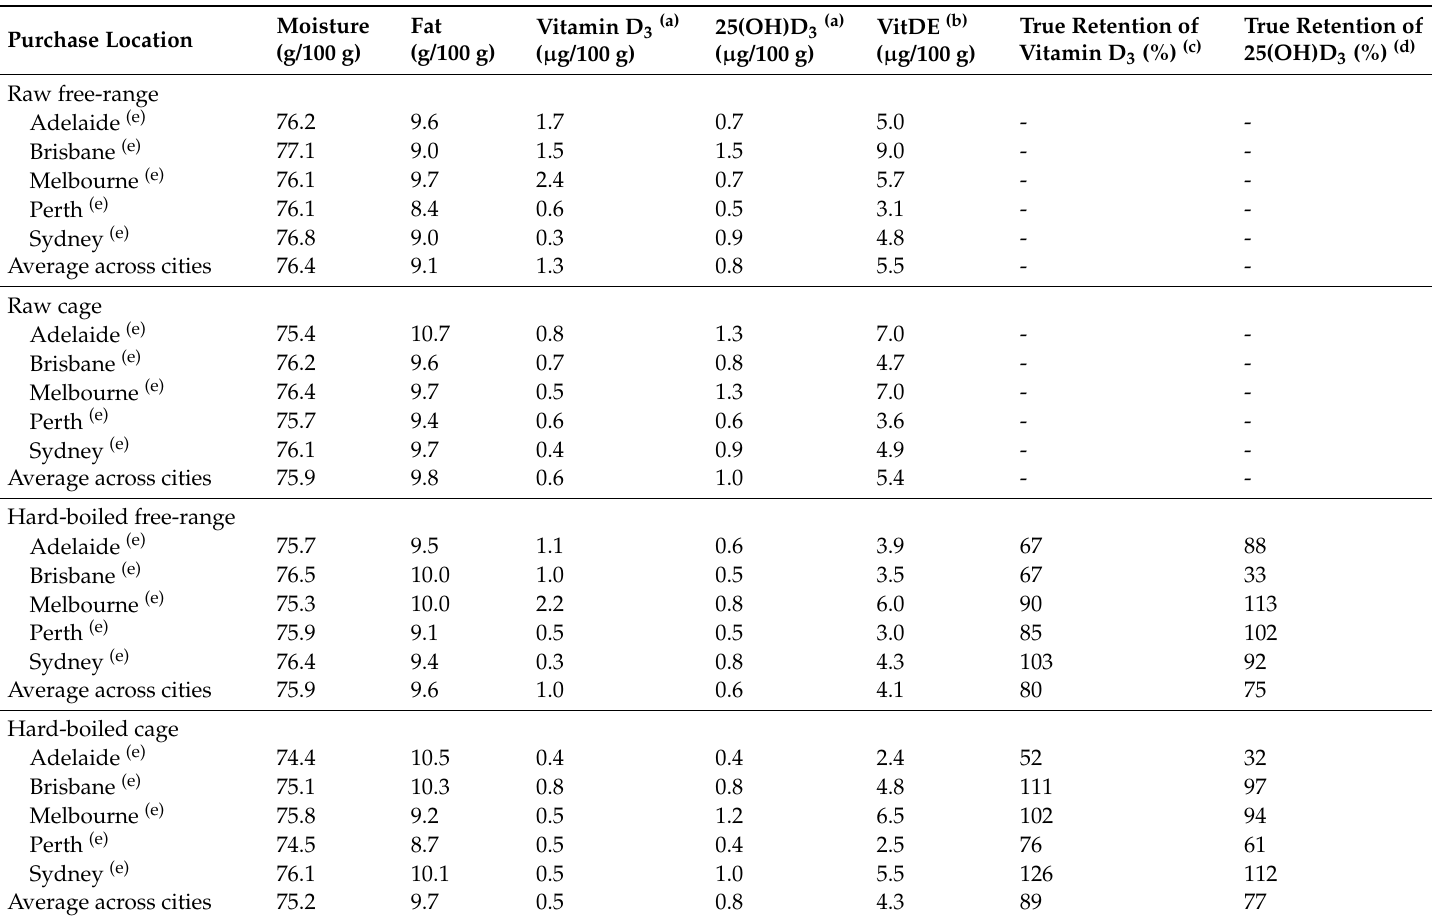
Table 3. New data for moisture, fat, vitamin D 3 , 25-hydroxyvitamin D 3 and vitamin D equivalents in chicken